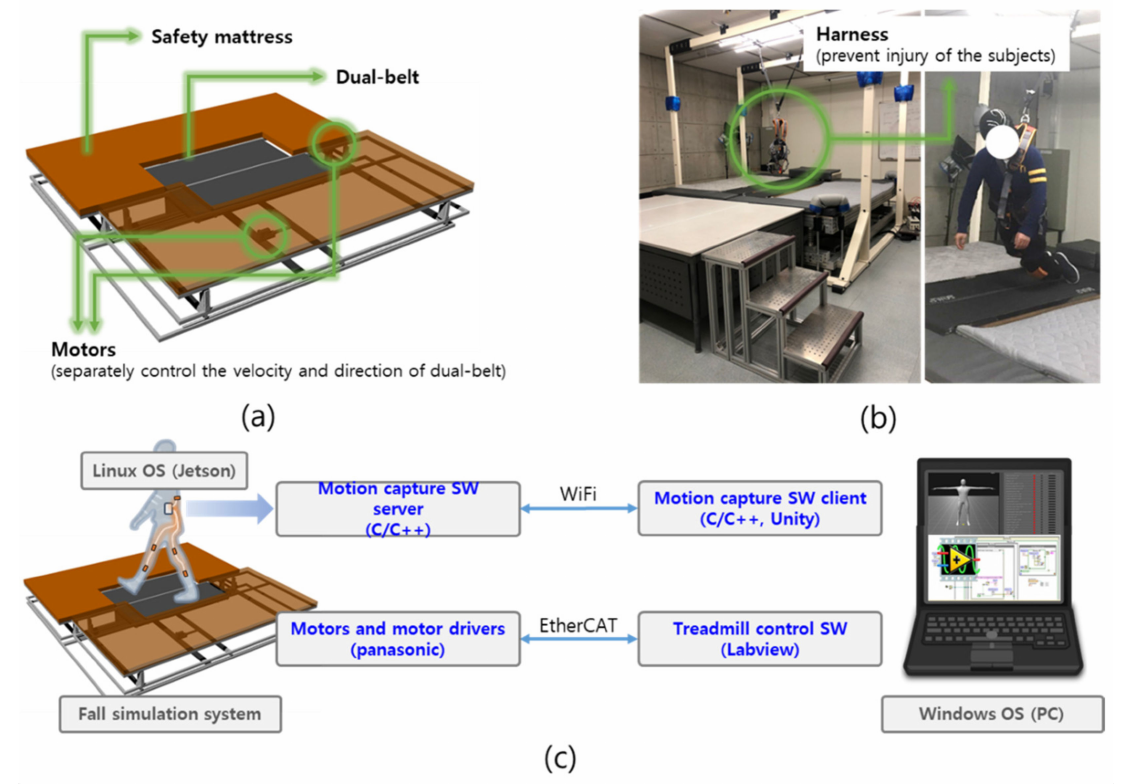
Figure 5. Dual-belt treadmill device for fall simulation experiment; ( a ) 3D-cad model of dual-belt treadmill device, ( b ) the fall simulation experimental system, and ( c ) data flow diagram of the system.